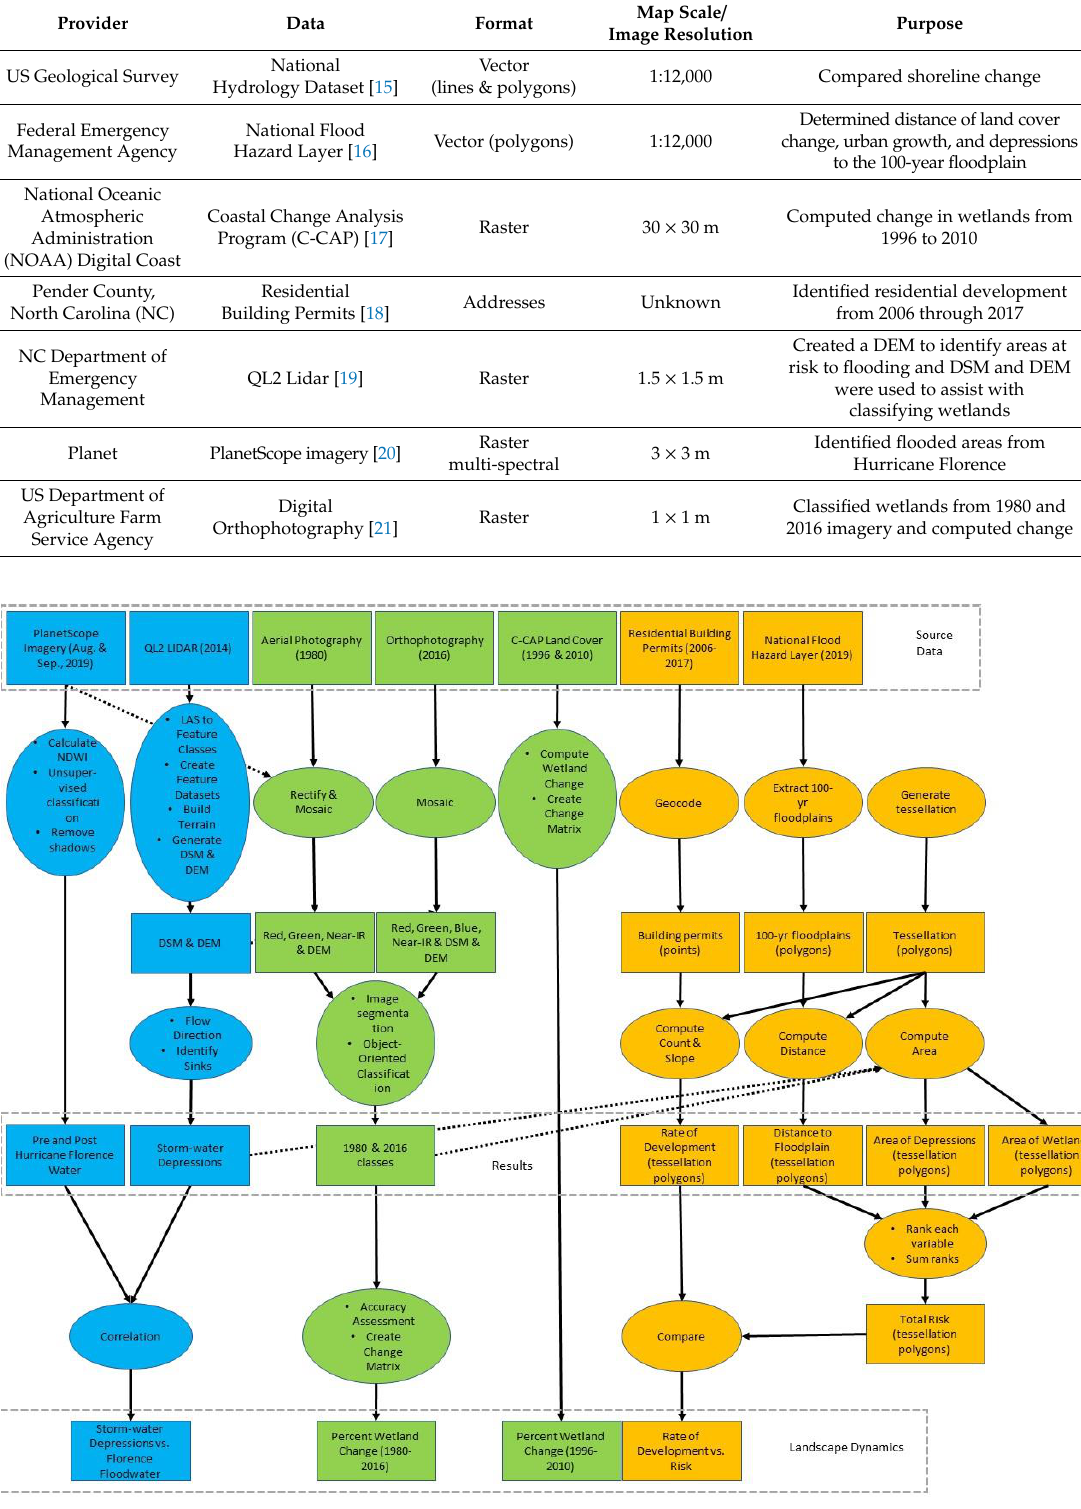
Figure 3. Project flowchart illustrating the methods for analyzing Hurricane Florence floodwater and potential storm-water depressions (blue), classifying wetlands and computing change through time (green), and identifying urbanization and coastal risk (orange).